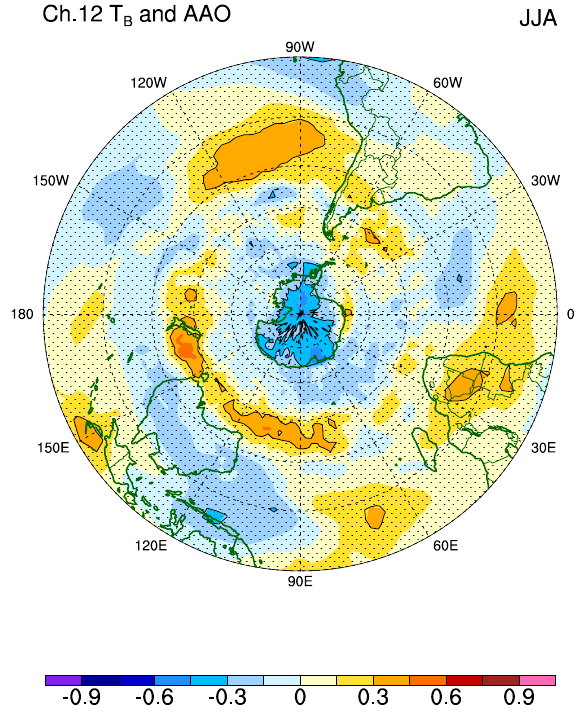
Fig. 12. Same as Fig. 7 for correlations between channel 12 T B and AAO index for